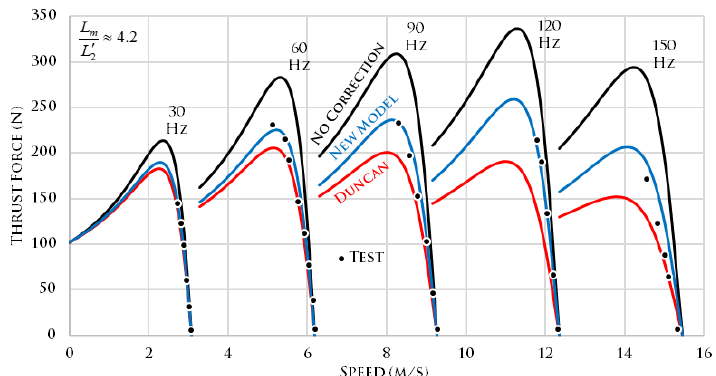
Figure 12. Comparison of thrust force through frequency variation (OD). Average gaps in ascending order [mm]: